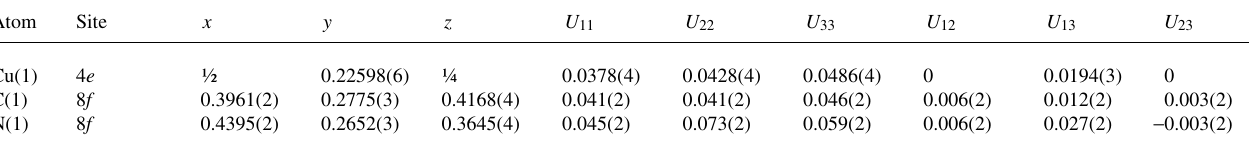
Table 3. Atomic coordinates and displacement parameters (in Å 2 )